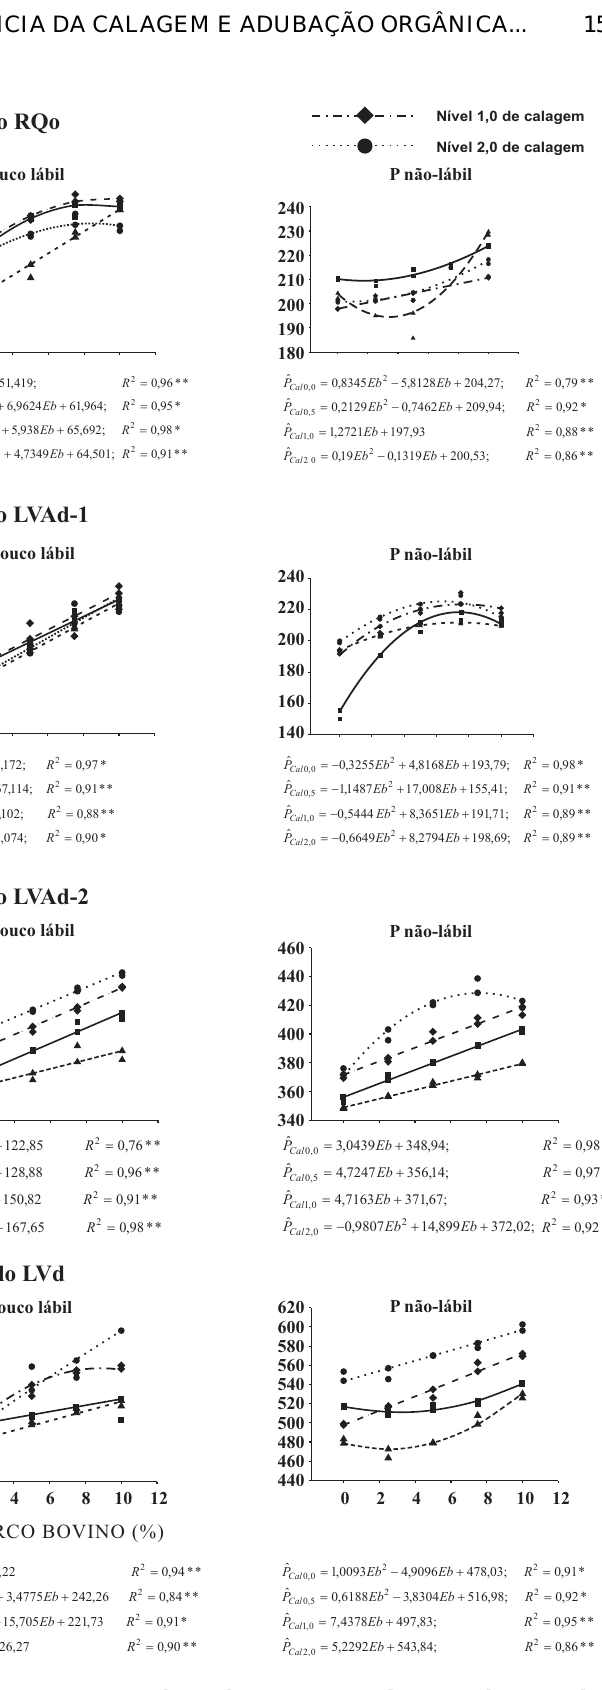
Figura 4. Distribuição das formas de P (mg dm -3 ) em amostras dos solos RQo, LVAd-1, LVAd-2 e LVd, em função da aplicação de esterco bovino ( Eb %), em cada nível de calagem ( Cal ). **; *: significativo a 1 e 5 %,